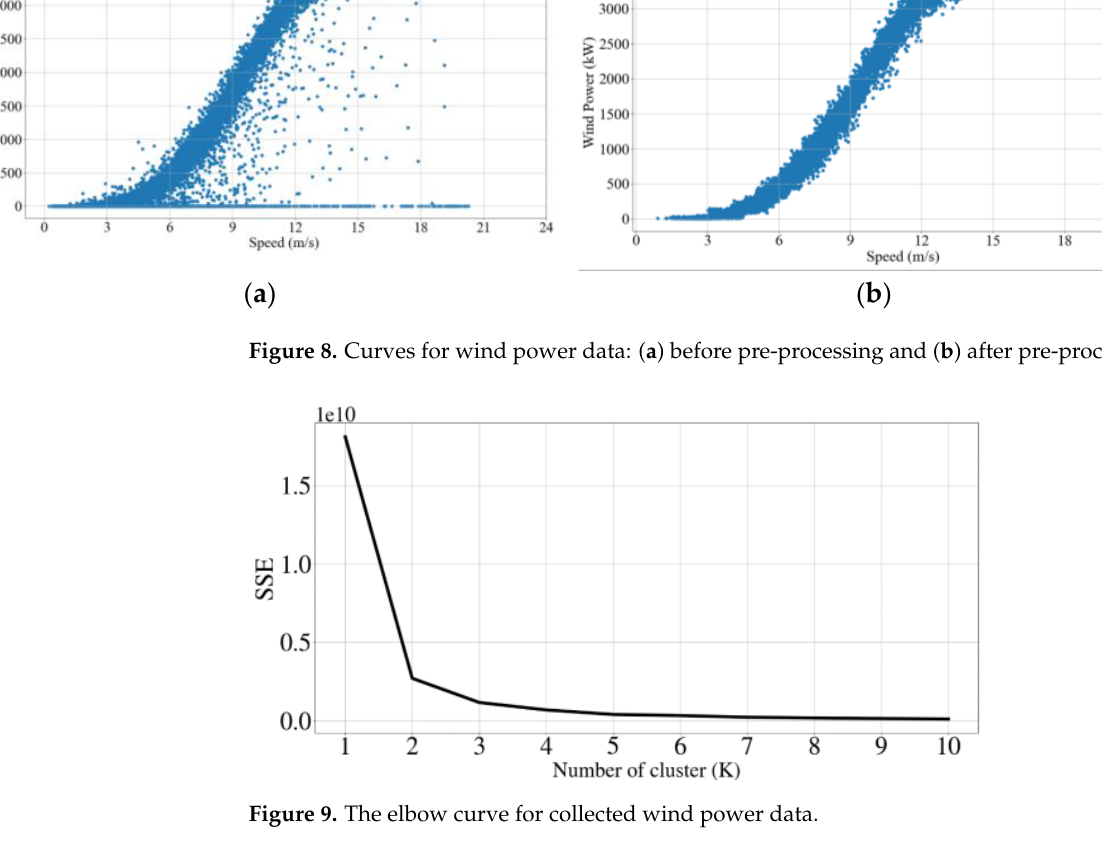
Figure 10. Wind power data classification using a k-means method. Table 2. Prediction error of data before and after classification. Data Type